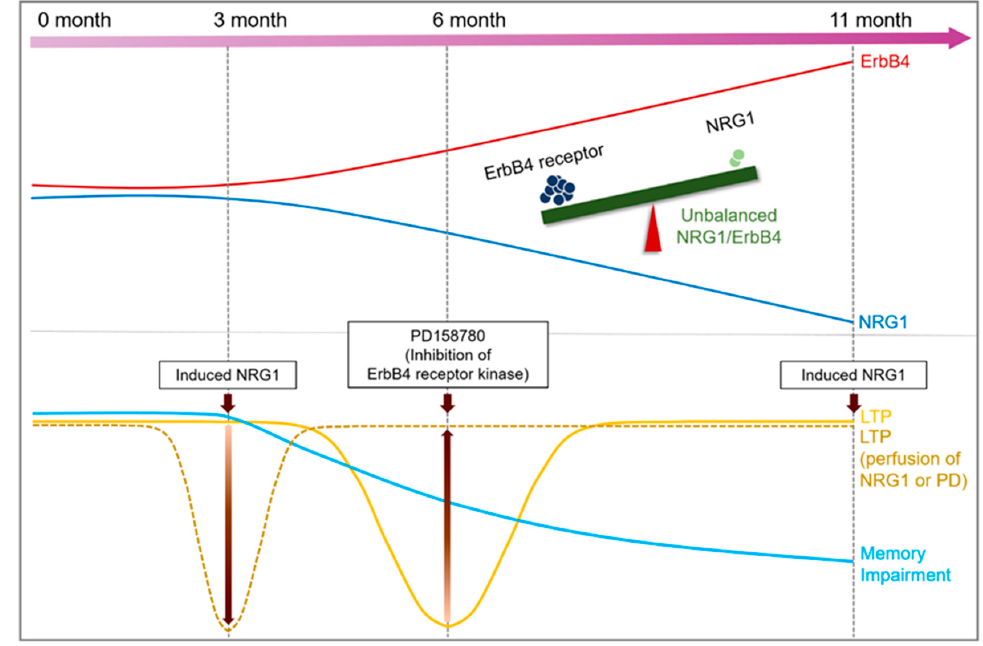
Figure 7. Schematic diagram of the hypothetical neuronal network of the time course in 5xFAD mice.